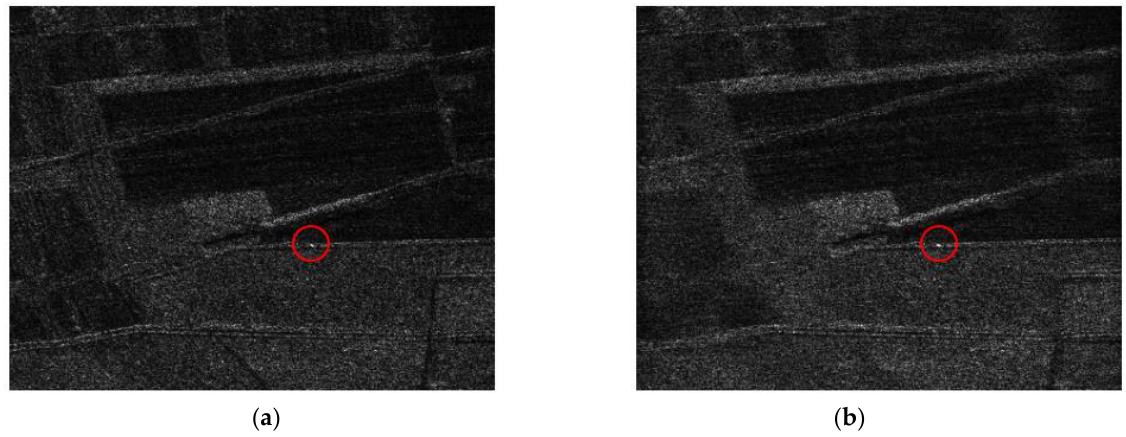
Figure 12. Image results obtained using ( a ) HSHD-AFBP and ( b ) HS-AFBP.